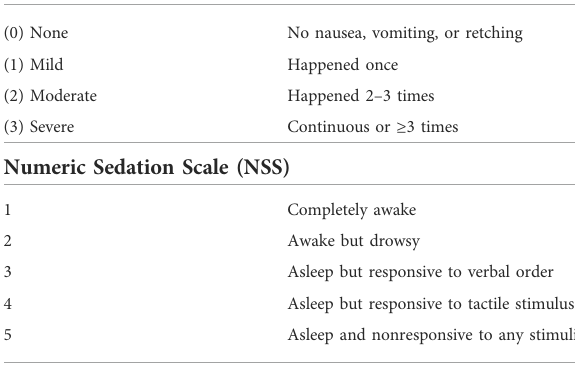
TABLE 1 Sedation and nausea/vomiting